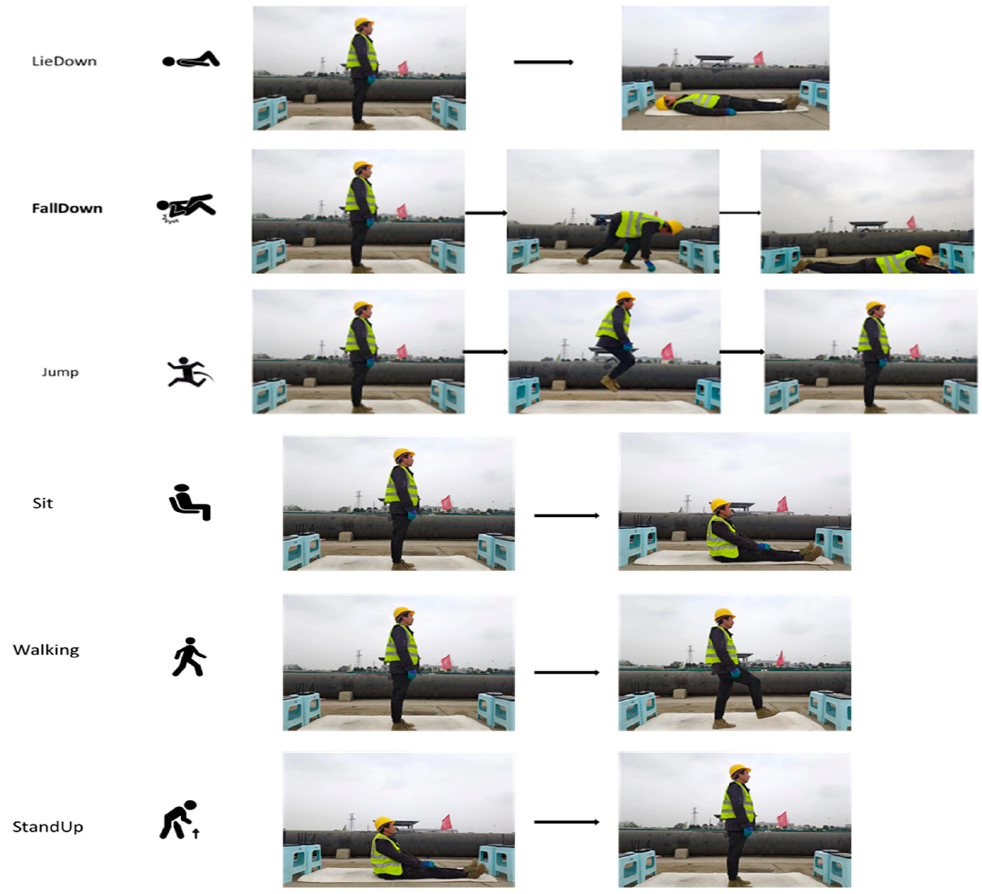
Figure 6. Details of six